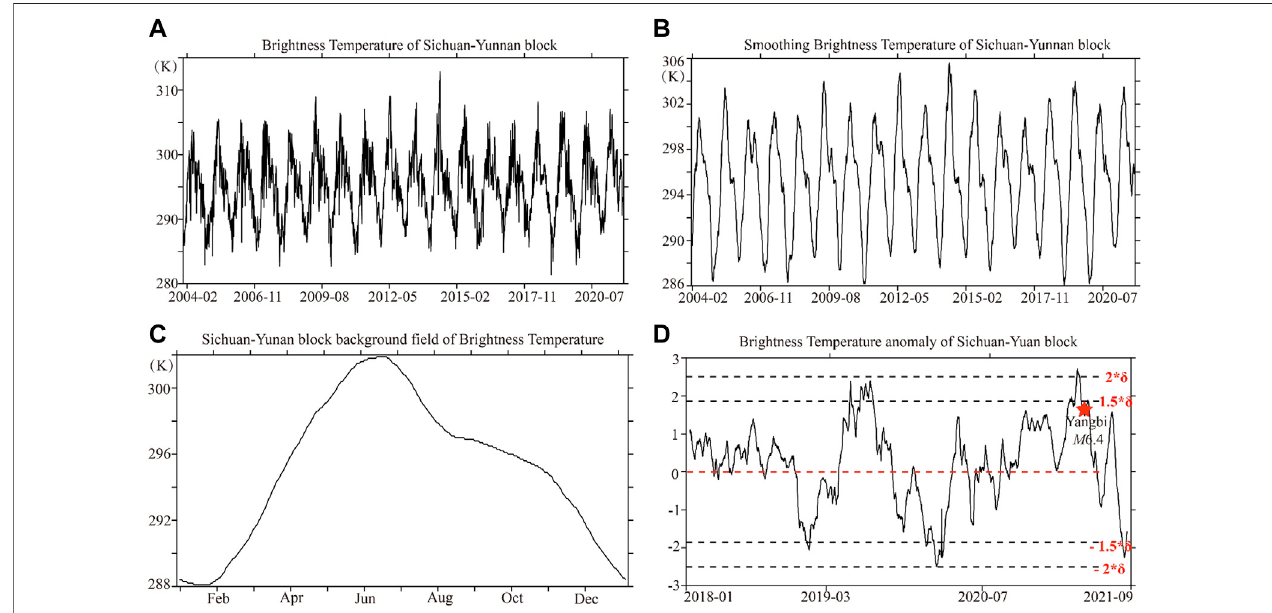
FIGURE 8 | BT in (A) time series, (B) smoothing BT (C) background fi eld of BT and (D) BT anomaly of the Sichuan-Yunnan Block.